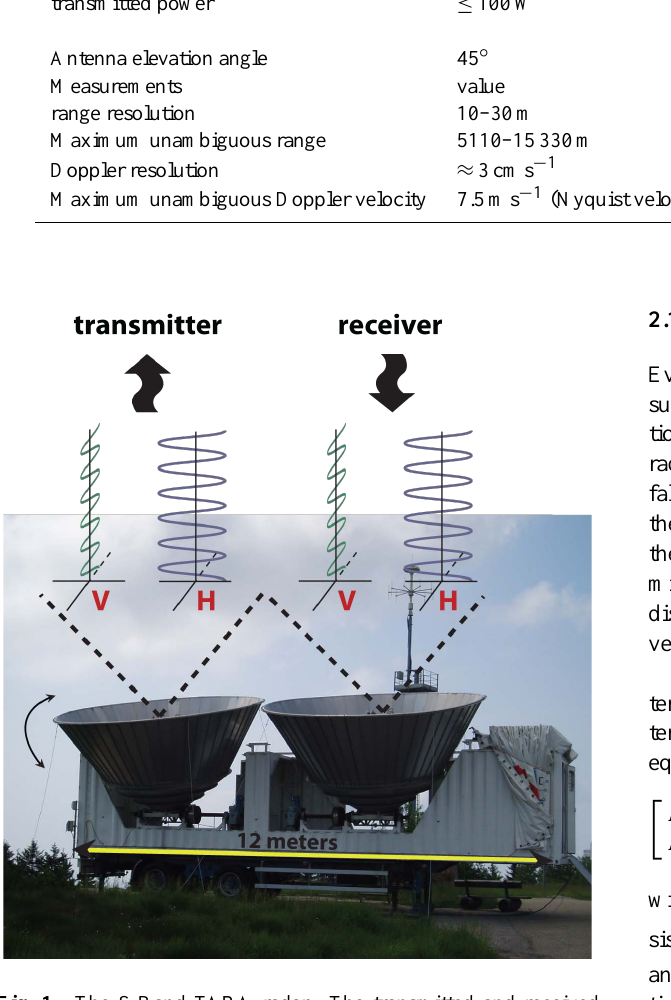
Fig. 1. The S-Band TARA radar. The transmitted and received signals are sequentially switched from vertical to horizontal polar- ization states in order to measure the full scattering